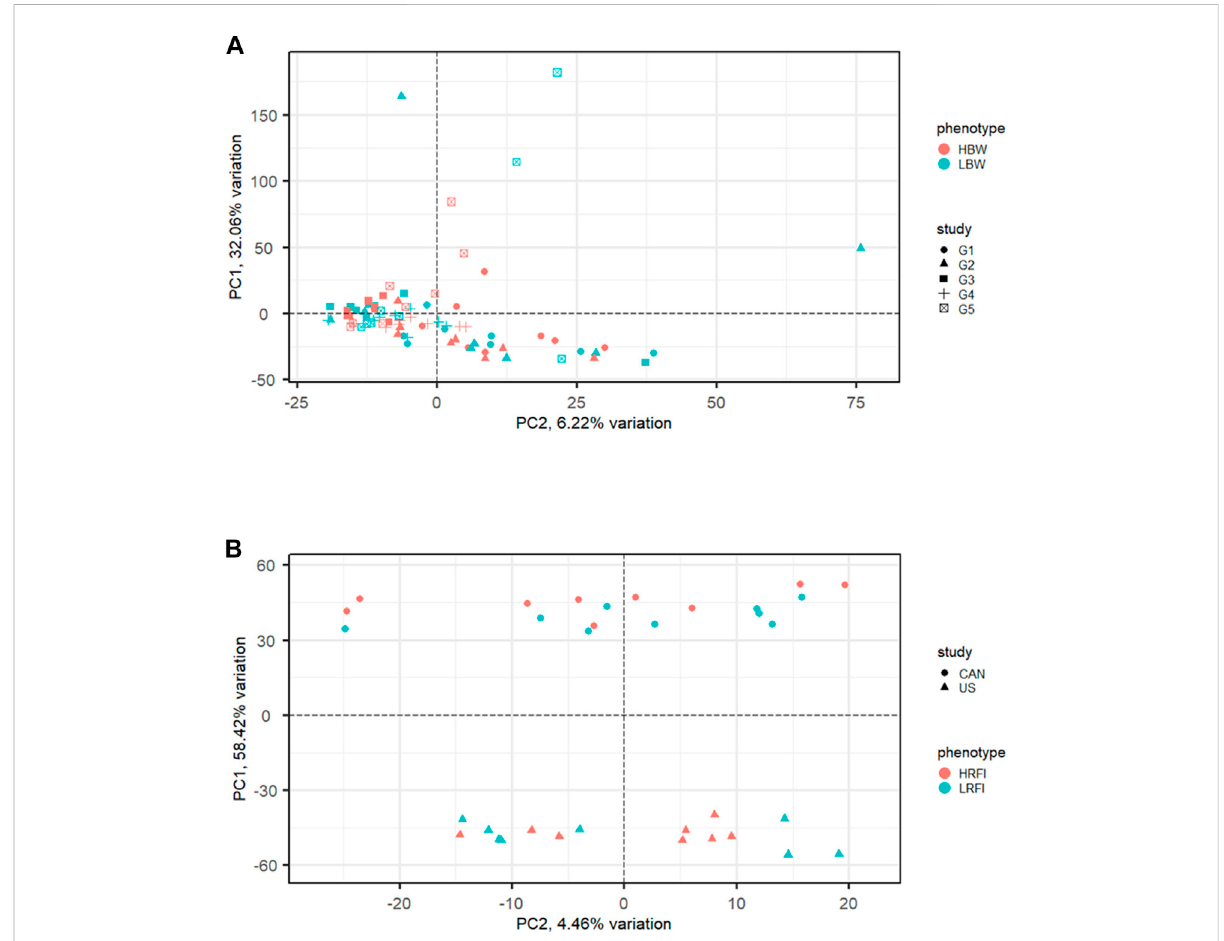
FIGURE 3 Examples of RNA-Seq data with low and high inter-study variability exhibited via principal components analysis (PCA). (A) Low inter-study variability in the muscle transcriptome of high (HBW) and low (LBW) body weight gain from fi ve cohorts of steers reared at the U.S. Meat Animal Research Center (Keel et al., 2018). (B) High inter-study variability in the rumen transcriptome of cattle with high (HRFI) and low (LRFI) residual feed intake from a Canadian population and a United States population (Lindholm-Perry et al.,